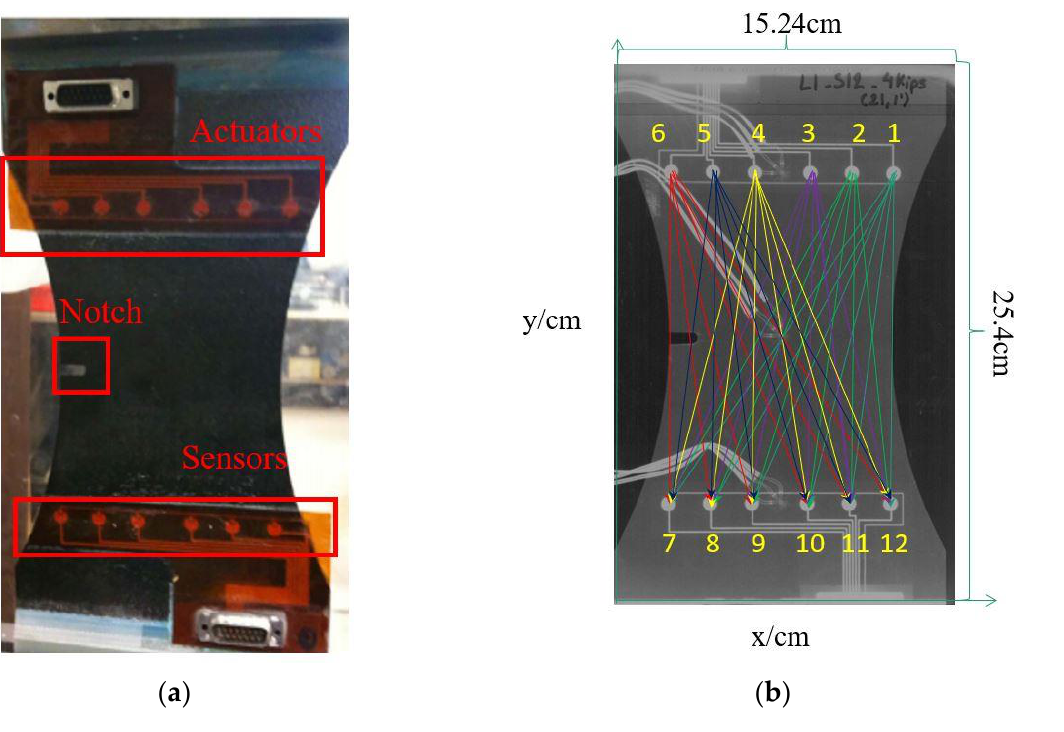
Figure 4. Experimental specimen and excitation-sensing channel schematic: ( a ) experimental speci- men; ( b ) excitation-sensing channel schematic.